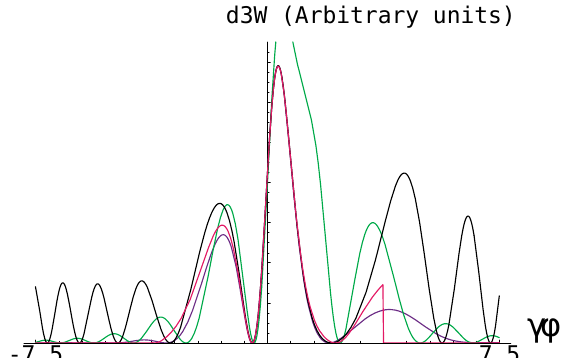
FIG. 14. (Color) ≠ 3 W s (cid:4) ≠v≠f≠c vs gf at c (cid:2) 0 , for two dipoles distant 0.5 m. The blue curve is the exact Fourier trans- form, the green curve is the low frequency model [Eq. (16)], the black curve is the first order v approximation [in Eq. (2)], and the red curve is the second order.